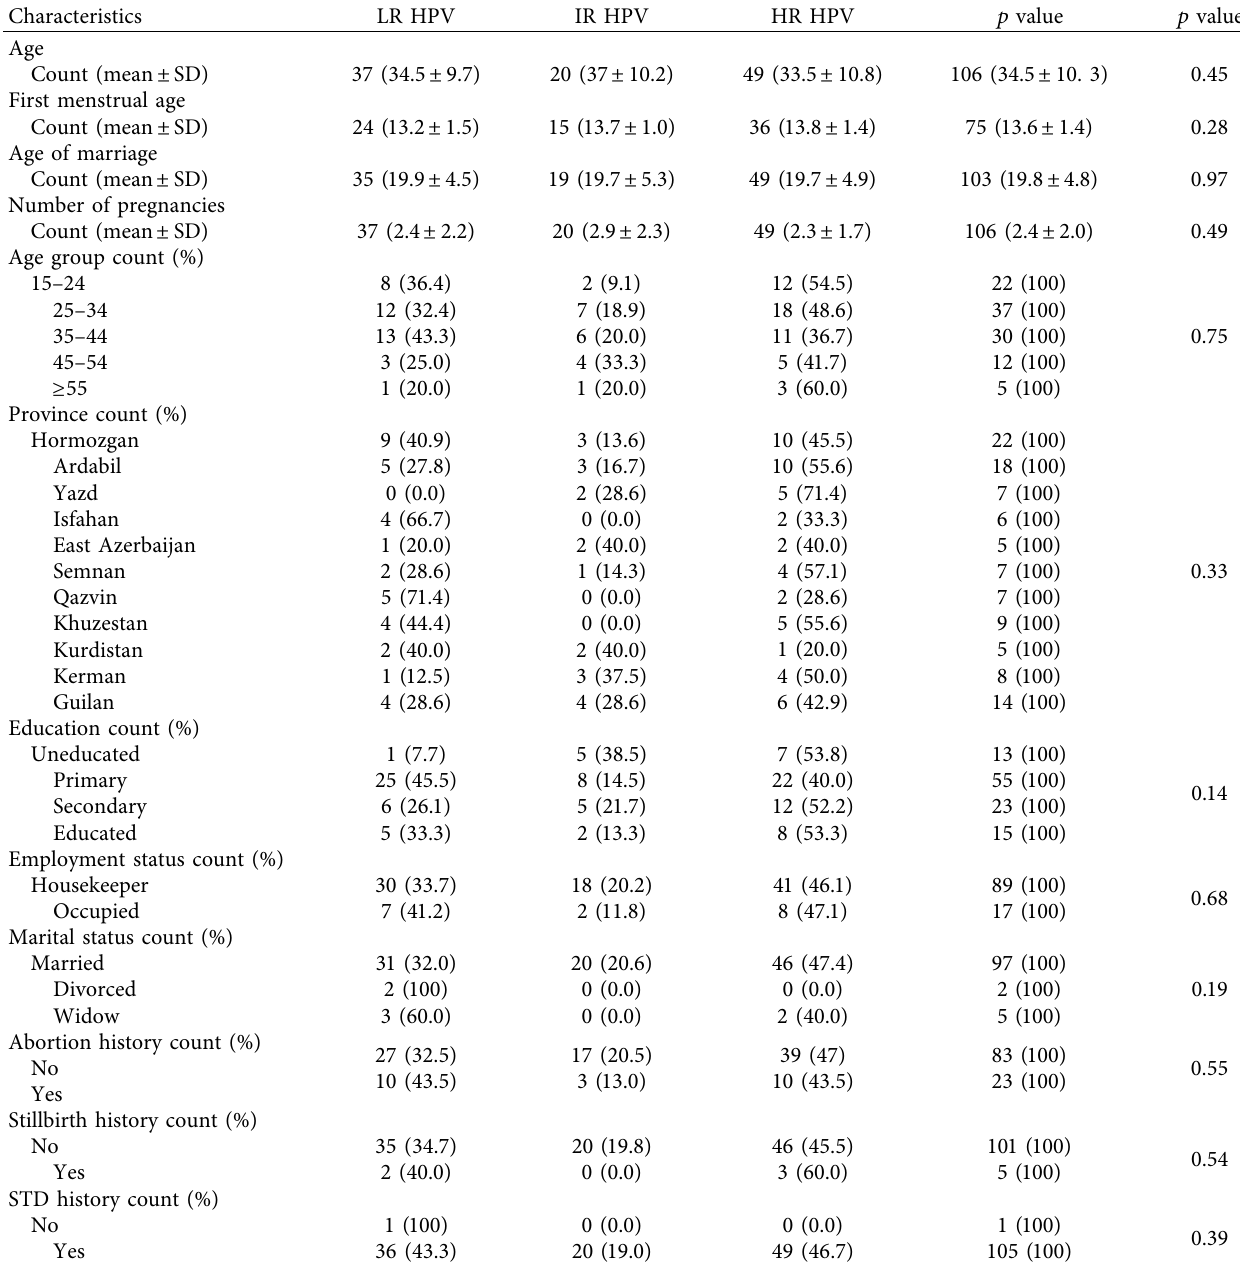
Table 2: Characteristics in all types of HPV positive